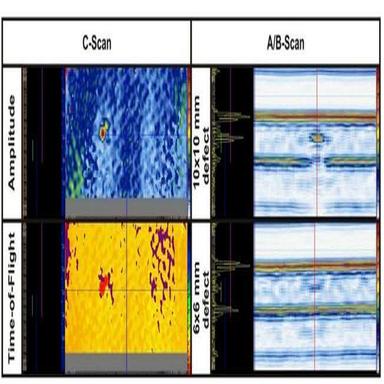
Ultrasonic investigation of panel 2.